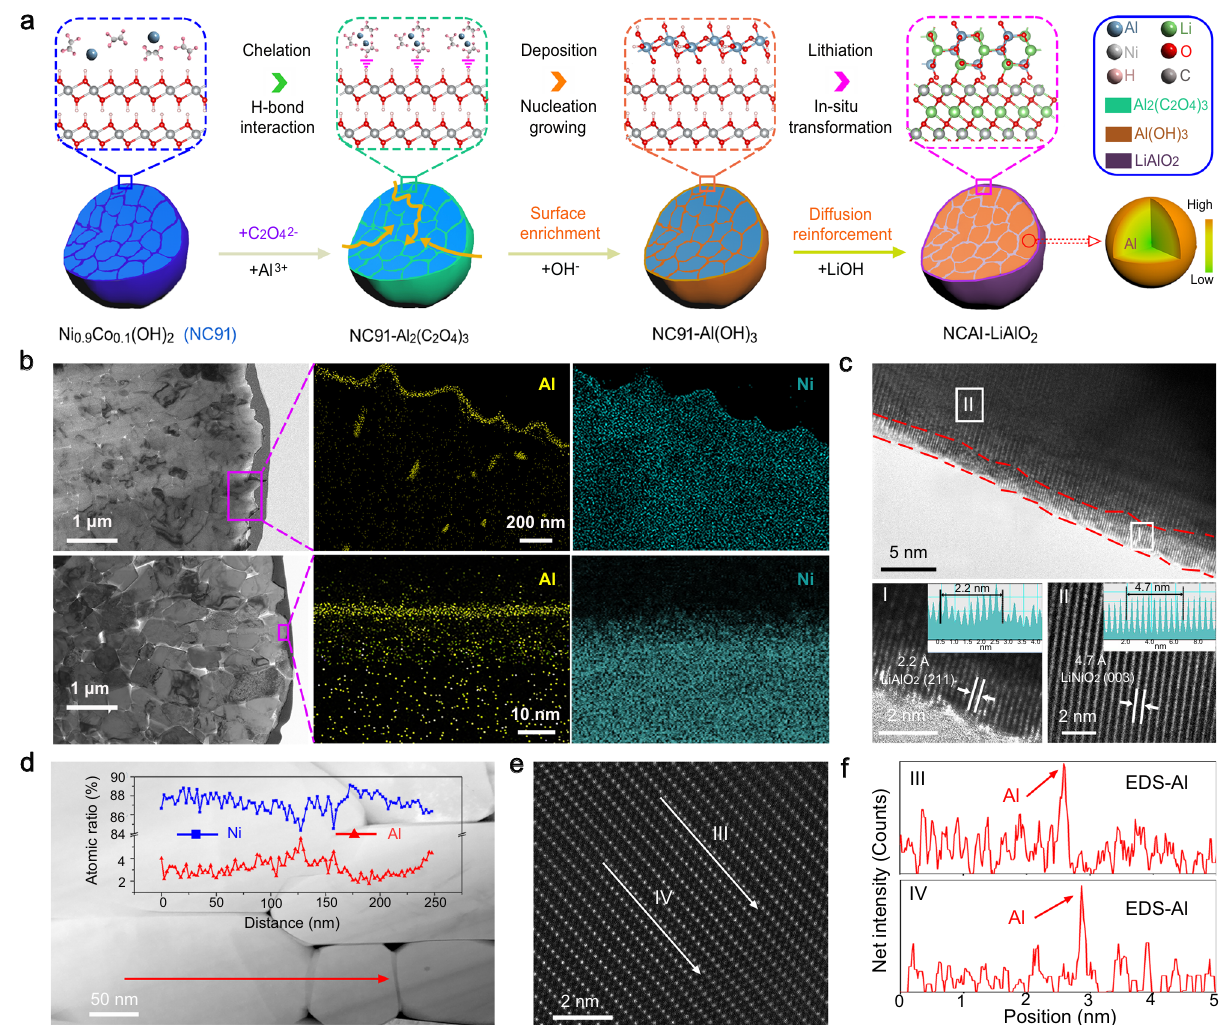
Fig. 2 Synthesis and characterisation of aluminium-modi fi ed cathodes. a Schematic illustration of synchronous gradient Al-doped and LiAlO 2 -coated LiNi 0.9 Co 0.1 O 2 cathode. b TEM images and corresponding EDS mapping of NC91-Al(OH) 3 and NCAl-LAO. Yellow dot for aluminium and green dot for nickel. c High-resolution TEM images of surface for NCAl-LAO. d STEM-HAADF image of internal particles and corresponding EDS element line distribution of Ni (blue line) and Al (red line). e , f Cs-STEM-HAADF image with corresponding EDS line analysis of Al (red line) between TM layer and Li layer. Red and white arrows for EDS line